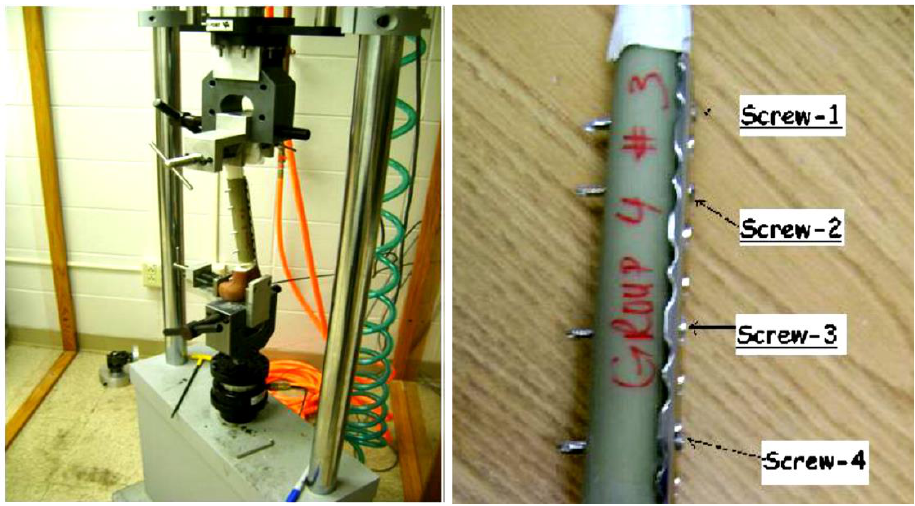
Figure 6. The synthetic bone with plate fixation in the EnduraTEC BOSE machine ( left ). The bone shaft showing the plate and screws [22] ( right ).